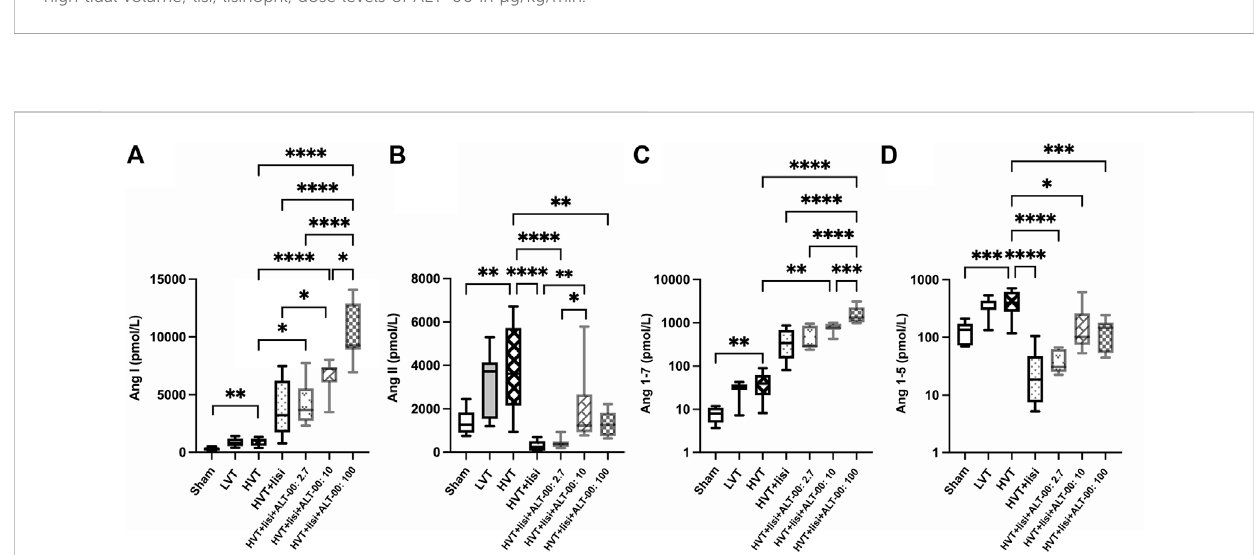
FIGURE 6 RAS equilibrium analysis. (A) Ang I concentrations were signi fi cantly elevated in the HVT group versus sham. Treatment with lisinopril (lisi) ± ALT-00 at all dose levels resulted in even higher levels of Ang I versus the HVT group. Moreover, lisi + ALT-00 at 100 μ g/kg/min led to a greater increase of Ang I levels than dose levels of 2.7 or 10 μ g/kg/min. (B) Ang II concentrations were signi fi cantly elevated in the HVT group versus sham. Treatment with lisi ± ALT-00atalldoselevelsresultedinadropofAngIIlevelsversustheHVTgroup.However,AngIIlevelswerehigherintheHVTgrouptreatedwithlisi + ALT-00 at 10 μ g/kg/min than in the groups treated with lisi alone or in combination with ALT-00 at 2.7 μ g/kg/min. (C) Ang 1-7 concentrations were elevated in the HVT group versus sham. Treatment with lisi + ALT-00 at dose levels of 10 and 100 μ g/kg/min elevated Ang 1-7 levels even further versus the HVT group. Moreover, additional ALT-00 at 100 μ g/kg/min increased Ang 1-7 levels more than 2.7 or 10 μ g/kg/min, or lisi alone. (D) Ang 1-5 concentrations were increased in the HVT group versus sham. Treatment with lisi ± ALT-00 led to considerably lower Ang 1-5 levels versus the HVT group. **** p < 0.0001, *** p < 0.001, ** p < 0.01, * p < 0.05, n = 7/group, compared by analysis of variance with Tukey posttest, logarithmic scale (log 10 ) on the y -axis in (C,D)